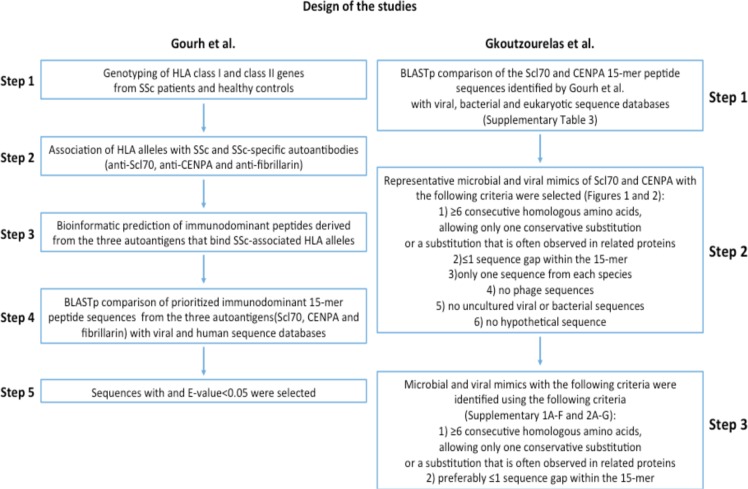
Step-wise approaches used by approaches used by Gourh et al.19 and the current study.